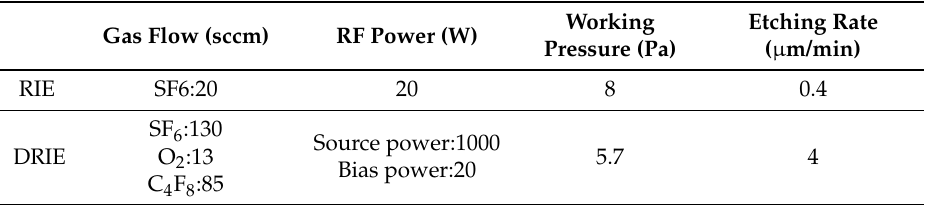
Figure 6. The fabrication process steps of the accelerometer. ( a ) Thermal oxidization; ( b ) ICP for the gap; ( c ) Light boron diffused for piezoresistors; ( d ) Heavy boron diffusion and metallization process; ( e ) RIE for front–side shape; ( f ) DRIE for back–side shape; ( g ) The BOX layer removed; ( h ) Anodic bonding between the SOI wafer and a Pyrex glass slide; ( i ) The top view of the chip. Table 4. The details about RIE and DRIE process.